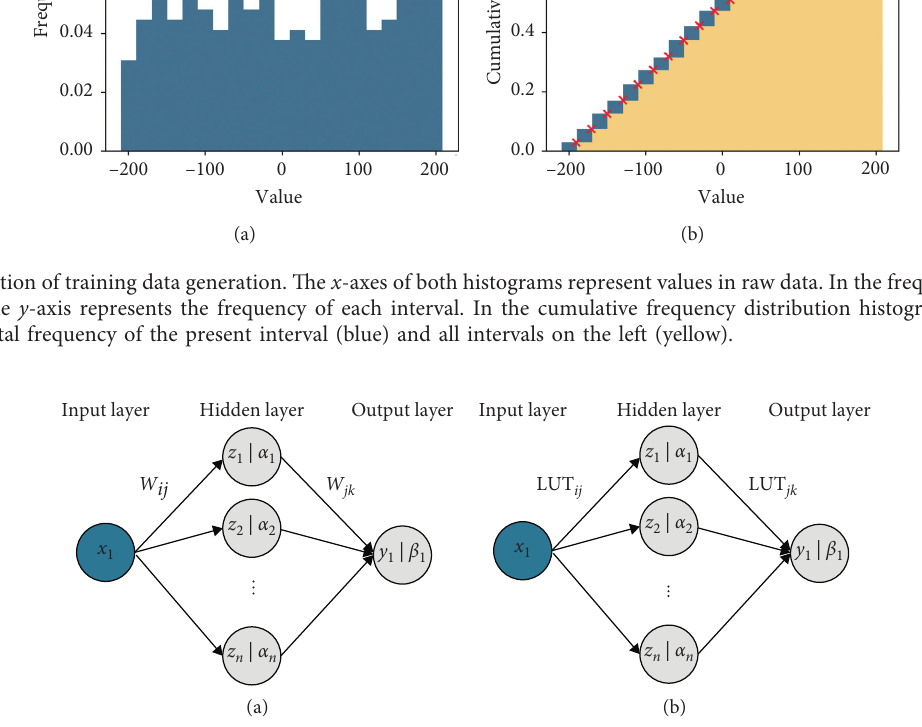
, one output node y , and 1 1